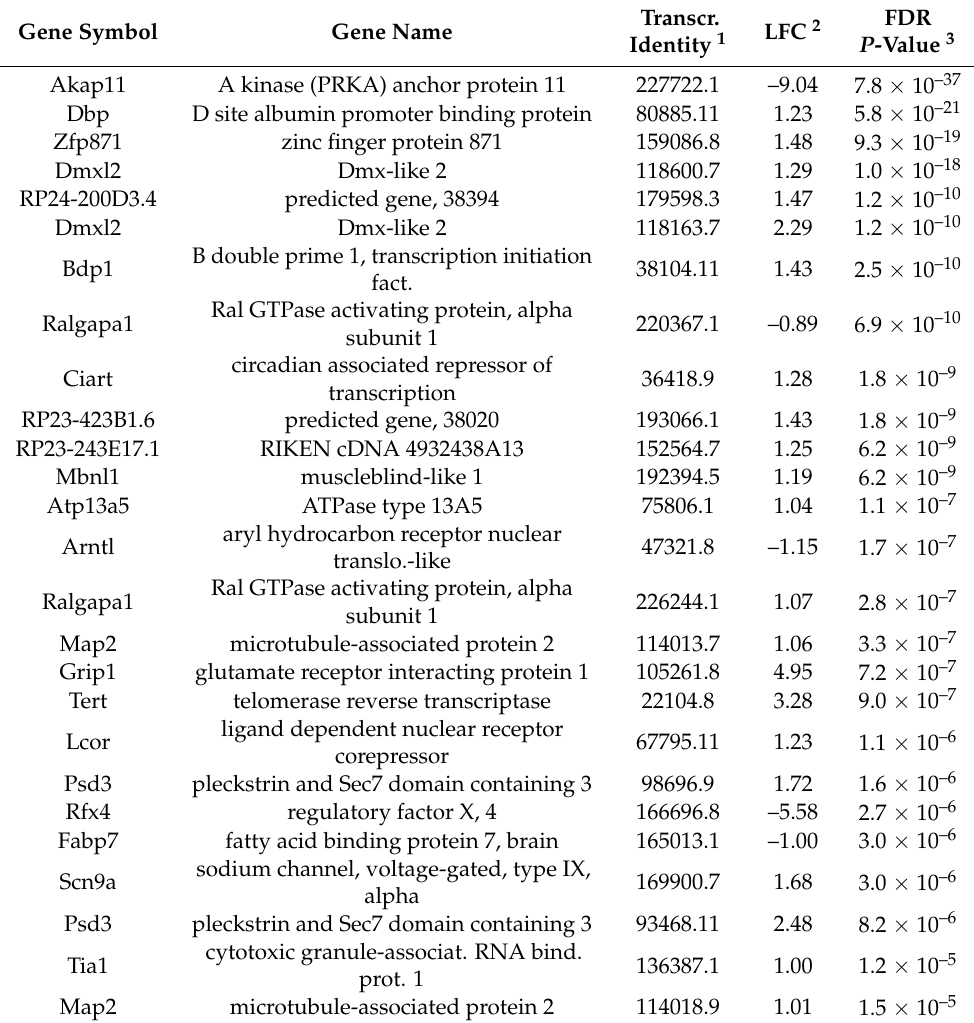
Table 2. Absolute differential expression of transcript isoforms (|fold change| > 2, FDR-adjusted P -value < 5.0 × 10 –5 ) between opioid-induced hyperalgesia and control mice in the trigeminal